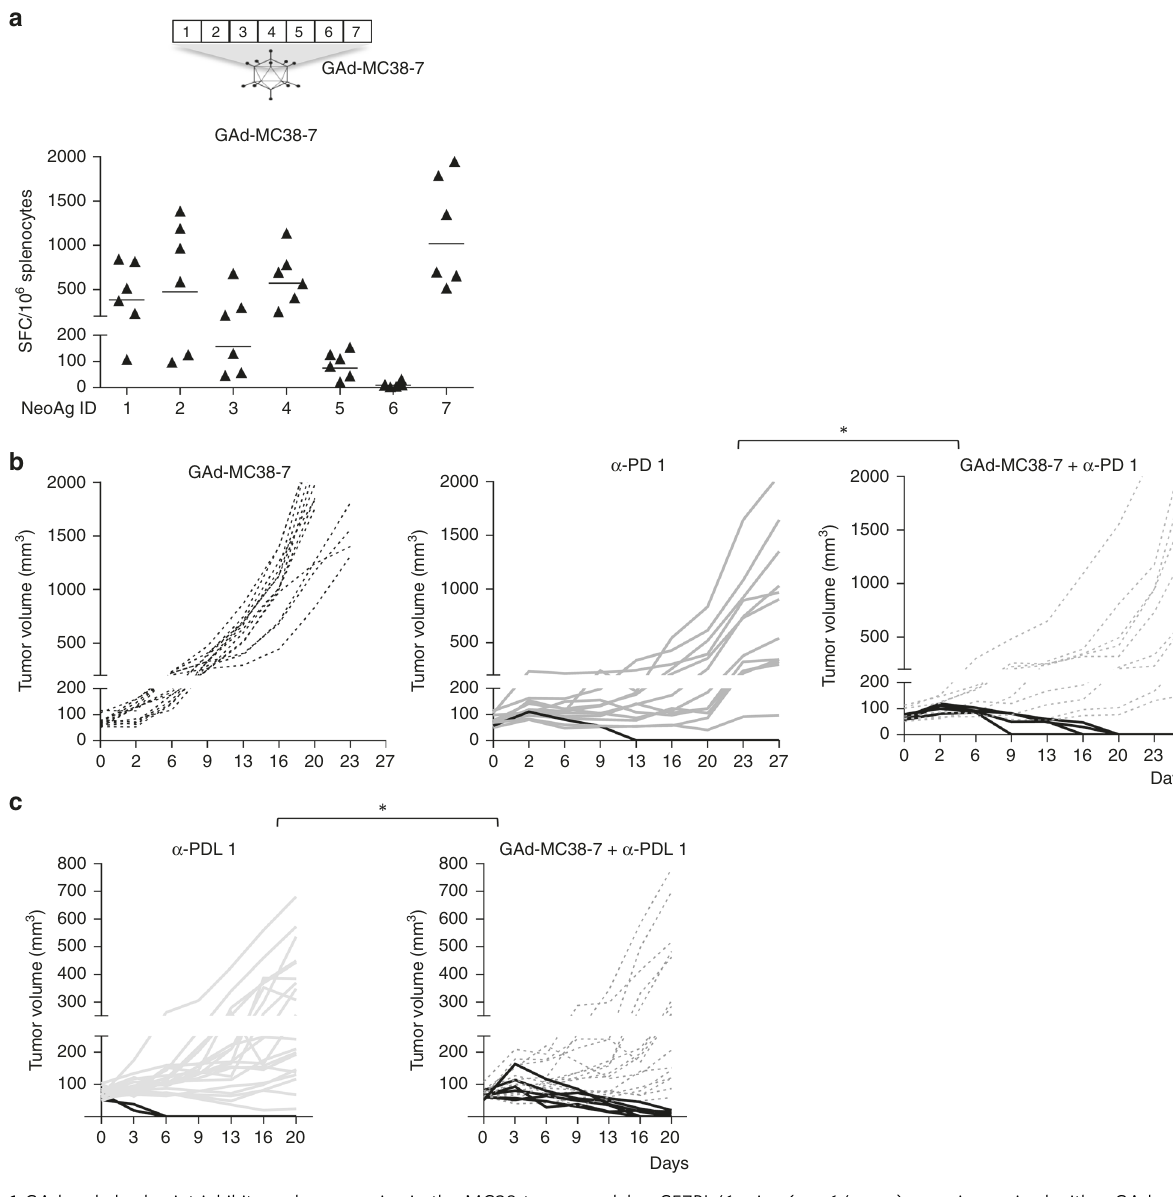
Fig. 6 GAd and checkpoint inhibitors also synergize in the MC38 tumor model. a C57BL/6 mice ( n = 6/group) were immunized with a GAd vector encoding seven MC38 neoantigens (GAd-MC38-7). Two weeks post vaccination, immune responses against the seven mutated peptides were measured on splenocytes. Data are representative of two independent experiments with six mice/group for each experiment. SFC = Spot Forming Cells. b , c Ef fi cacy of GAd-MC38-7 alone and in combination with anti-PD1 b or anti-PDL1 c . Treatment with GAd vaccine started at day 0, on mice randomized according to tumor volume. Mice showing complete tumor shrinkage post treatment are identi fi ed by black lines. Data represent at least two independent experiments ( n = 8 – 10/group) (Fisher test. * p